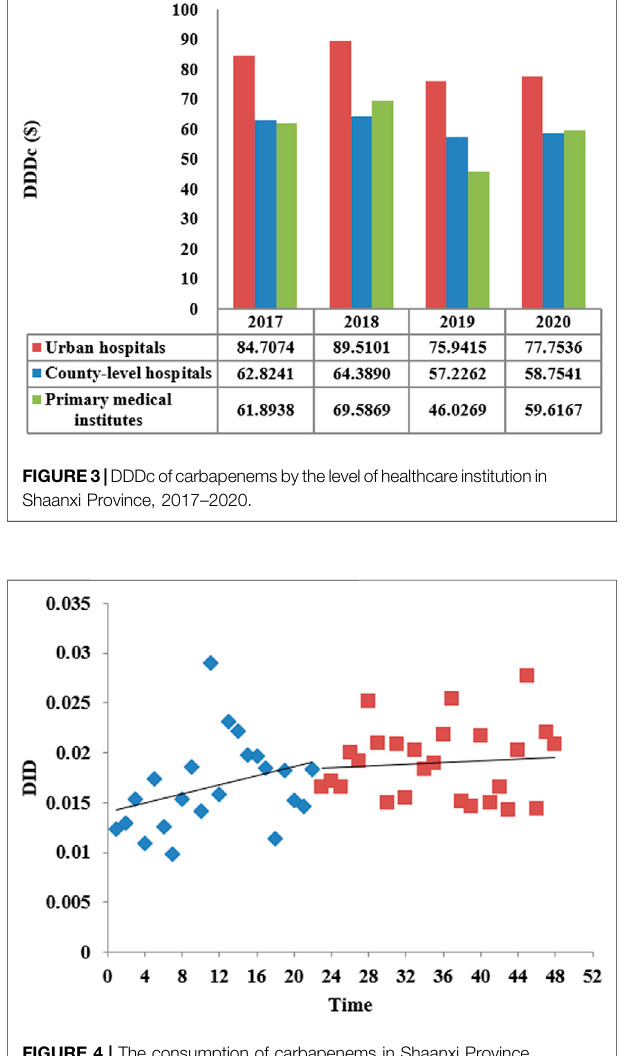
FIGURE 5 | The percentage of carbapenem expenditure to total antimicrobial expenditure, 2017 –